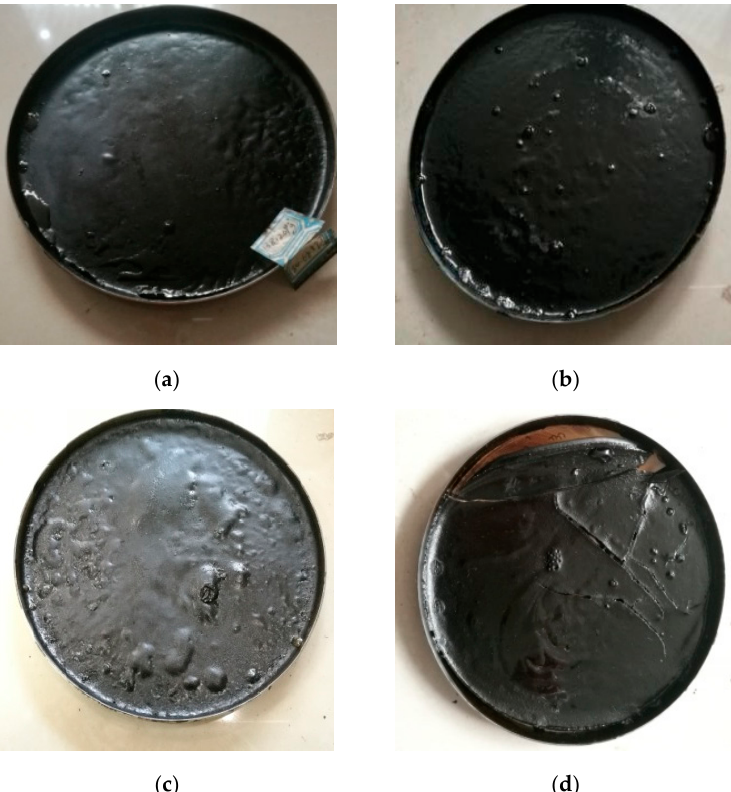
Figure 15. All levels of aging appearance: ( a ) level-I; ( b ) level-II; ( c ) level-III; ( d ) level-IV. Table 5. UV aging test results.